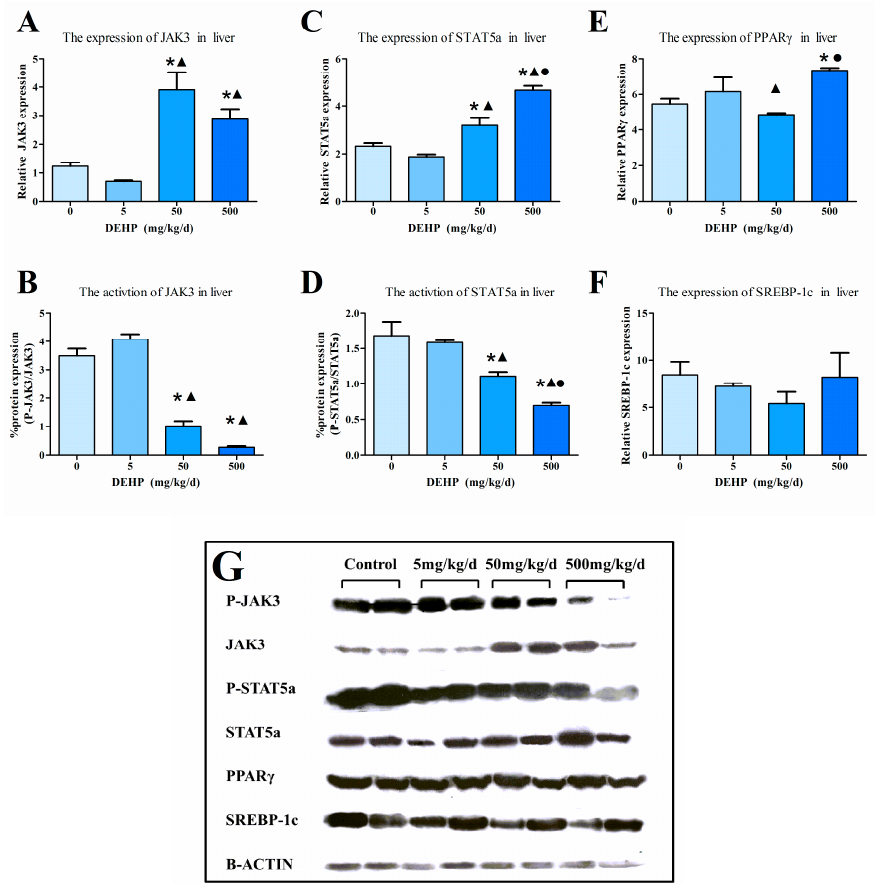
Figure 5. Western blot determination of proteins in the liver ( n = 20 animals/ each group): ( A ) The densitometric scans of JAK3/ β -actin; ( B ) The densitometric scans of P-JAK3/JAK3; ( C ) The densitometric scans of STAT5a/ β -actin; ( D ) The densitometric scans of P-STAT5a/STAT5a; ( E ) The densitometric scans of PPAR γ / β -actin; ( F ) The densitometric scans of SREBP-1c/ β -actin; ( G ) Western blot assay of JAK3, P-JAK3, STAT5, P-STAT5a, PPAR γ and SREBP-1c expression in the liver after DEHP treatment. The histogram represents the mean ± SE of the densitometric scans for protein bands from each group and normalized to β -actin. ● Statistically signi fi cant di ff erence compared with 50 mg·kg − 1 ·d − 1 ( p < 0.05); ▲ Statistically significant difference compared with 5 mg·kg − 1 ·d − 1 ( p < 0.05); * Statistically significant difference compared with control ( p < 0.05).